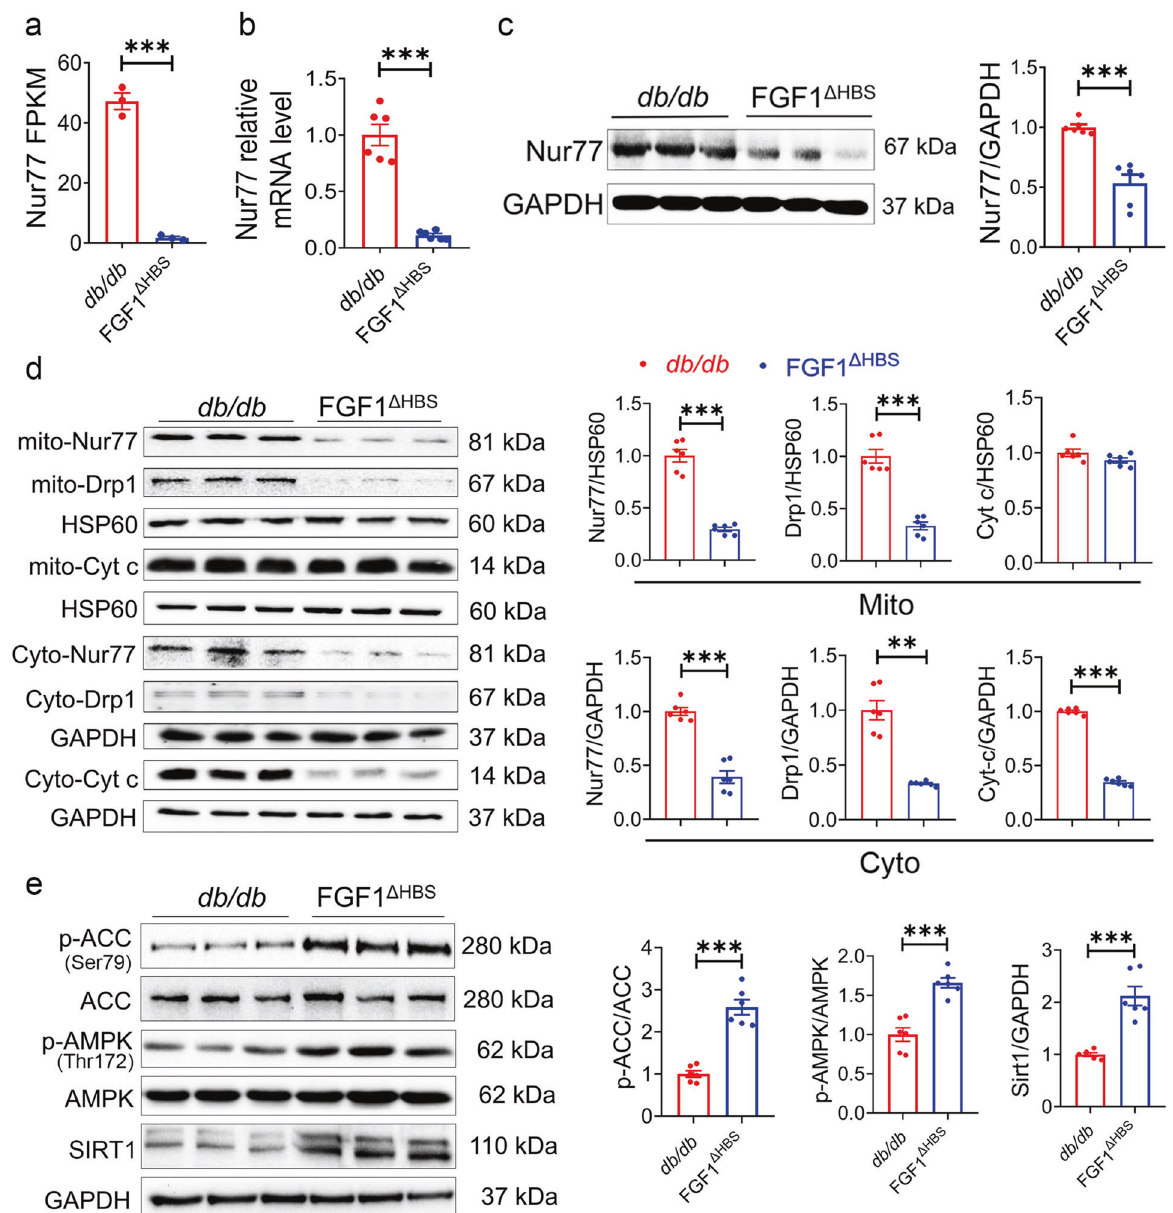
Fig. 5 FGF1 Δ HBS suppresses Nur77 expression and activates AMPK in the hearts of db/db mice. a FPKM values of Nur77 gene in the RNA-Seq analysis. n = 3. b Nur77 mRNA levels con fi rmed by qPCR. n = 6. c Western blot analysis (left panel) and densitometric quanti fi cation (right panel) of Nur77 in the cardiac tissues. GAPDH was a loading control. n = 6. d Western blot analysis (left panel) and densitometric quanti fi cation (right panel) of Drp1, Nur77 and Cyt C in cardiac tissues of each group. HSP60 and GAPDH were loading controls. n = 6. e Western blot analysis (left panel) and densitometric quanti fi cation (right panel) of p-ACC, ACC, p-AMPK, AMPK α 2 and SIRT1 in the cardiac tissues. GAPDH was a loading control. n = 6. Data were mean ± SEM; ** P < 0.01, *** P <